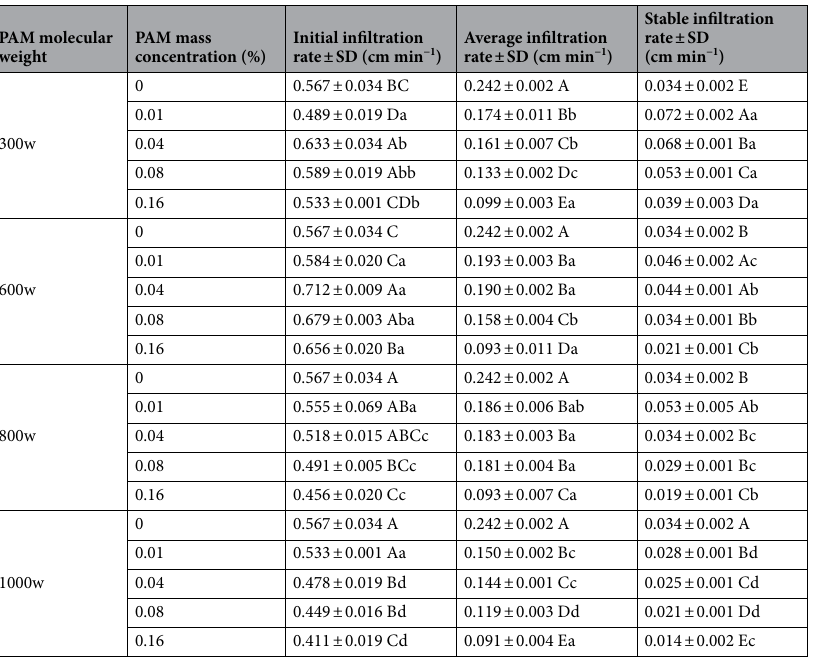
Table 1. Initial infiltration rate, average infiltration rate and stable infiltration rate for four molecular weight (300w, 600w, 800w and 1000w) and five mass concentration (0%, 0.01%, 0.04%, 0.08% and 0.16%) of PAM. S.D. means the standard derivation among the repetitions (n = 3). Different capital letters indicate the significant difference in infiltration rate under different mass concentrations of PAM with the same molecular weight, and different lowercase letters indicate the significant difference in infiltration rate under different molecular weight PAM treatments when the mass concentration of PAM is the